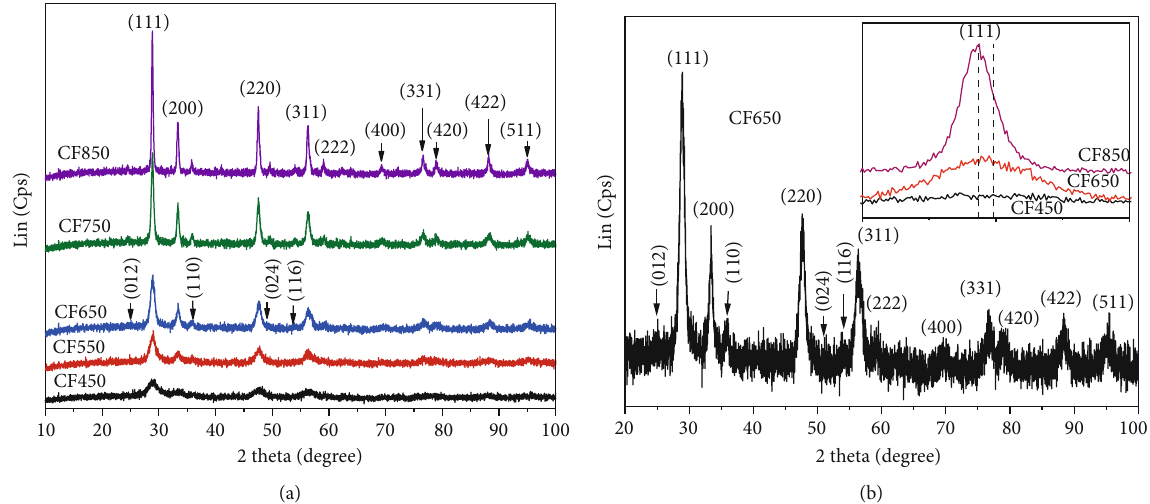
-Fe O mixed oxides. Samples with the CF molar ratio of 1 :1 calcined at di ff erent temperatures for 2 h (a) 2 2 3